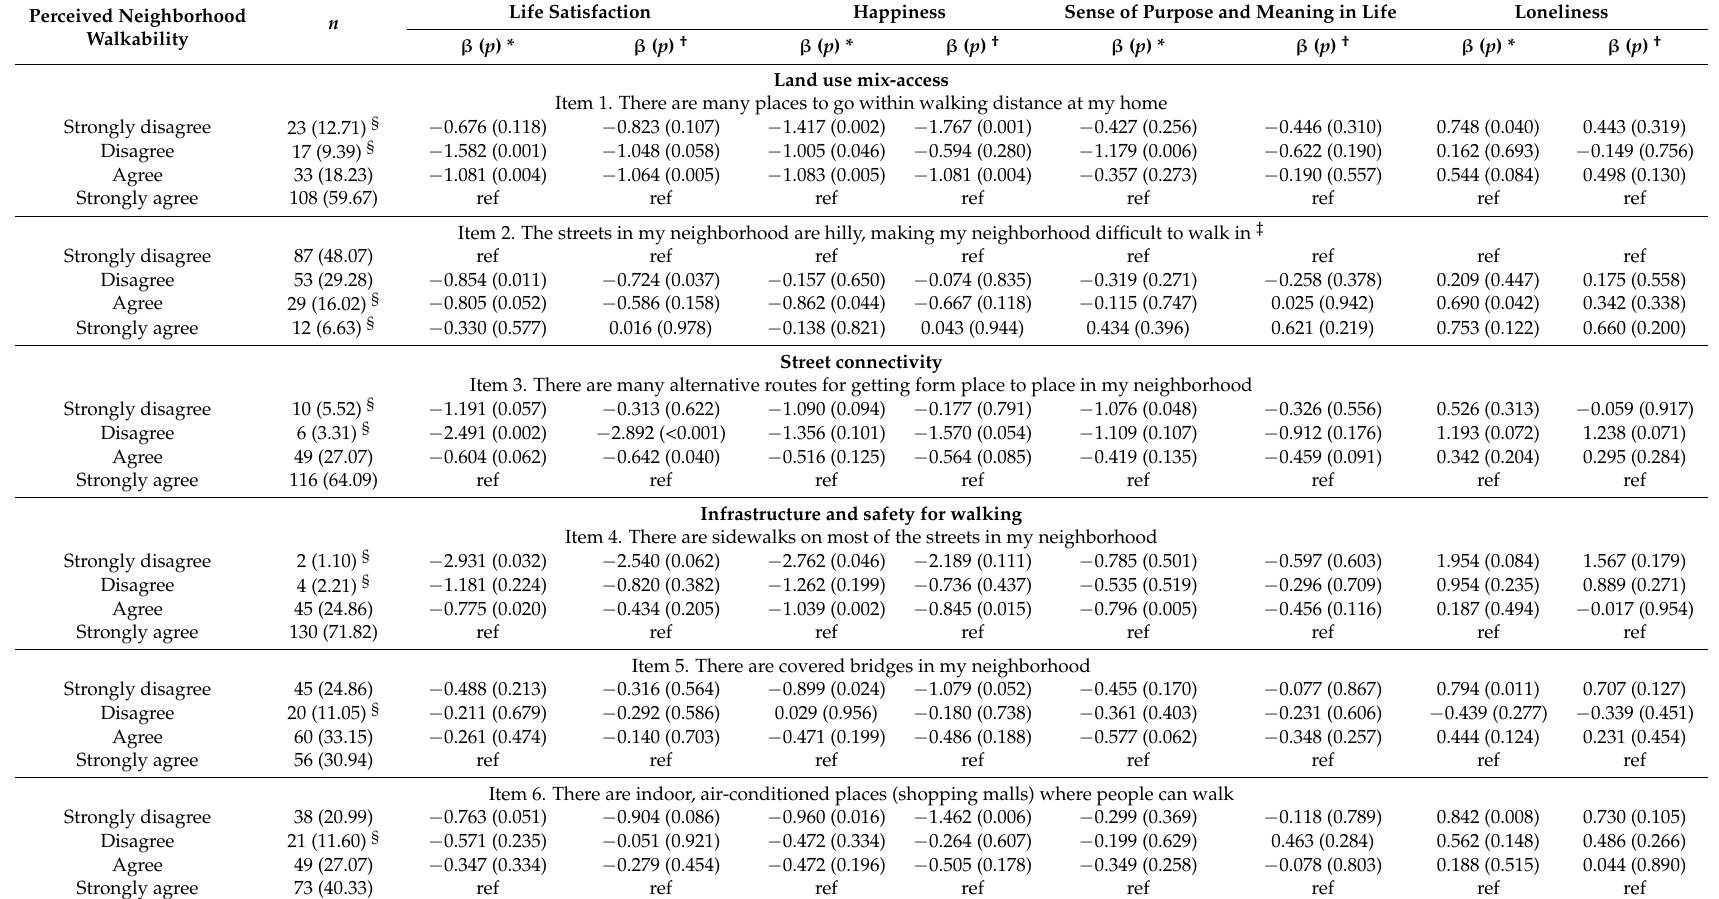
Table 5. Crude and adjusted associations of individual items of perceived neighborhood walkability with measures of wellbeing and loneliness ( n = 181). Life Satisfaction Happiness Sense of Purpose and Meaning in Life Perceived Neighborhood n Walkability